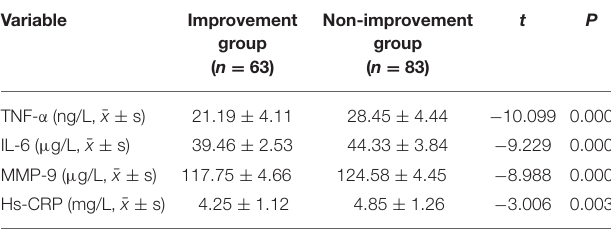
TABLE 3 | Comparison of the levels of inflammatory factors.